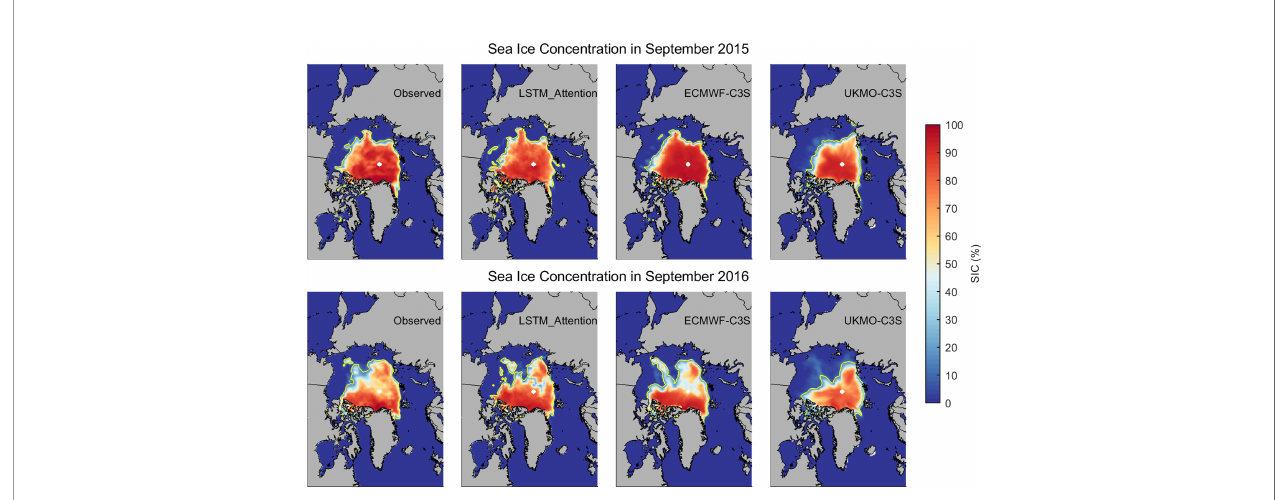
FIGURE 7 | Observed and predicted Arctic SIC by LSTM_Attention, ECMWF-C3S and UKMO-C3S in September 2015 (upper panel) and September 2016 (lower panel). The yellow line in each subplot represents the observed or predicted ice edge for that month.